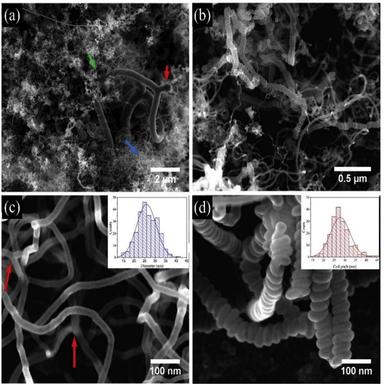
SEM images from S5. (a) Low magnification image showing carbon nano- and micro-materials. (b) Small diameter carbon nanotubes and helical carbon nanostructures. (c) High magnification images of multiwalled carbon nanotubes (c) and helical carbon structures (d). The insets in (b) and (c) show the diameter and the coin pitch distributions, respectively. (A colour version of this figure can be viewed online.)